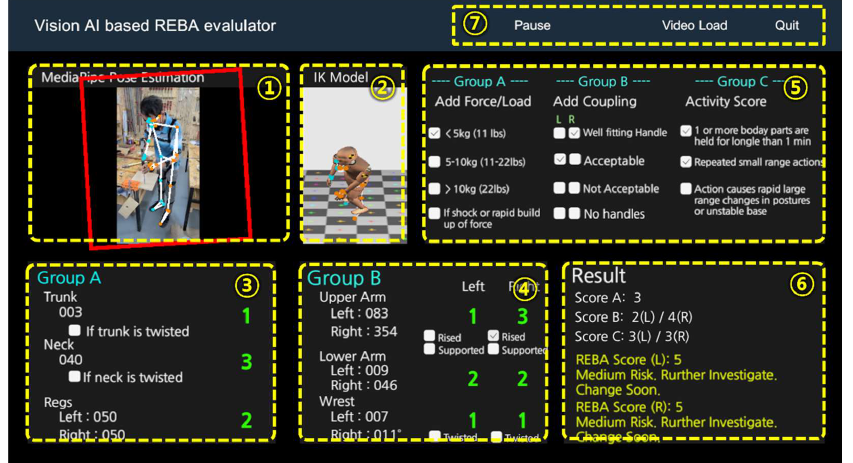
Figure 10. GUI of REBA evaluation system using